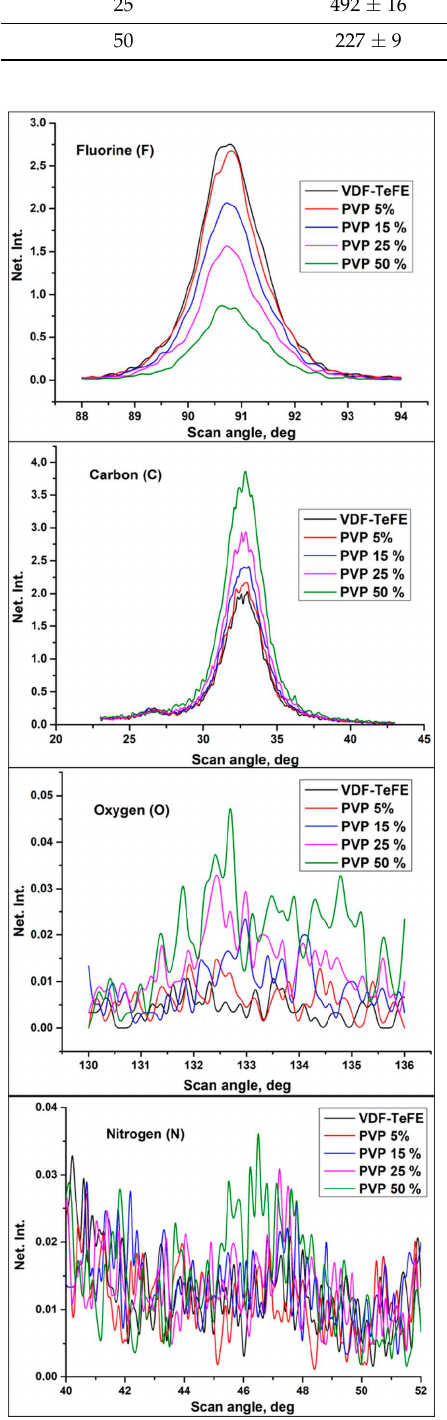
Figure 2. Fluorescent spectra in the VDF–TeFE membranes with different PVP contents.